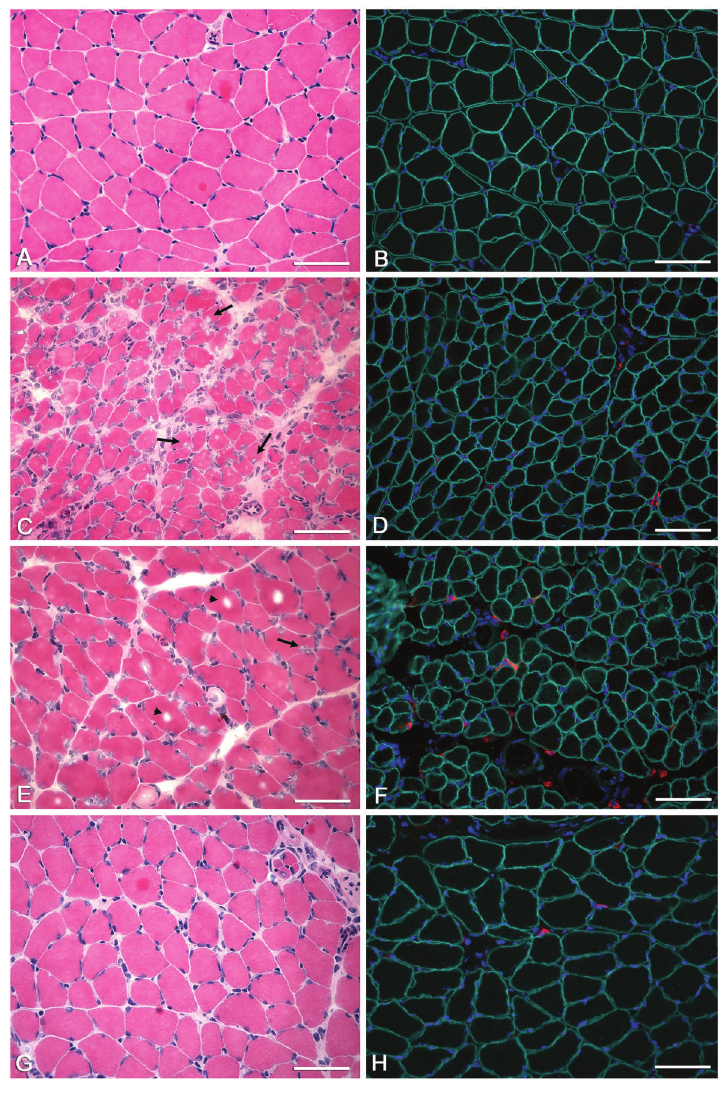
CG21 and IG and ISG (CG21 (cid:1) IG, CG30 (cid:1) IG, and CG21 (cid:1) ISG: P o 0.05; Table 1 and Figure 2). The semi-quantitative grading of the picrosirius red staining indicated that the fragments of soleus muscle from all groups showed moderate to strong positive staining ( ++ / +++ ) (Table 2 and Figure 3). The staining for type I collagen was moderately positive ( ++ ) in IG and slightly positive ( + ) in all of the other groups (Table 2 and Figure 3). The staining for type III collagen was moderately positive ( ++ ) in all groups. The staining for type IV collagen was strongly positive ( +++ ) in the CG21, CG30, and SG animals, while it was moderately positive ( ++ ) in IG and ISG animals (Table 2 and Figure 3).